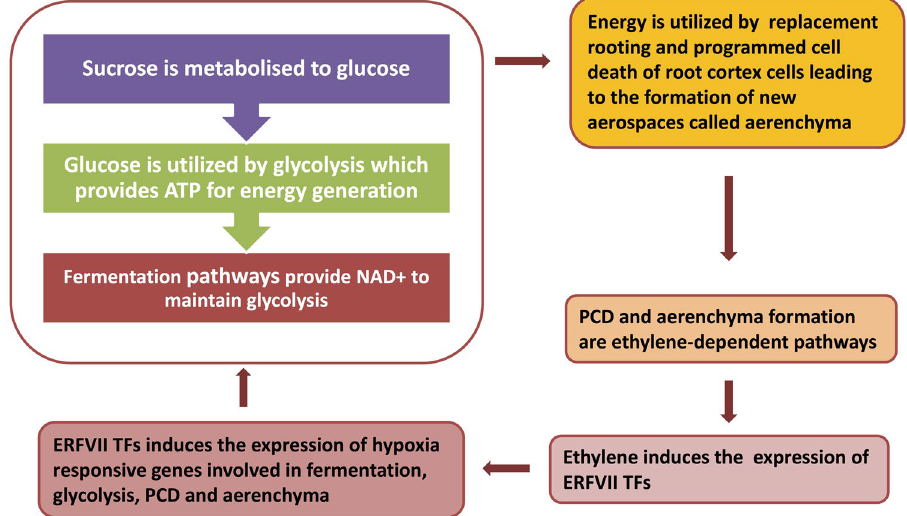
Figure 6. Crosstalk of different pathways regulated in waterlogging tolerant genotype under stressed condition to sustain the biological activities. Water-logging tolerance governed by interactions among several metabolic events viz ., glycolysis, programmed cell death, aerenchyma